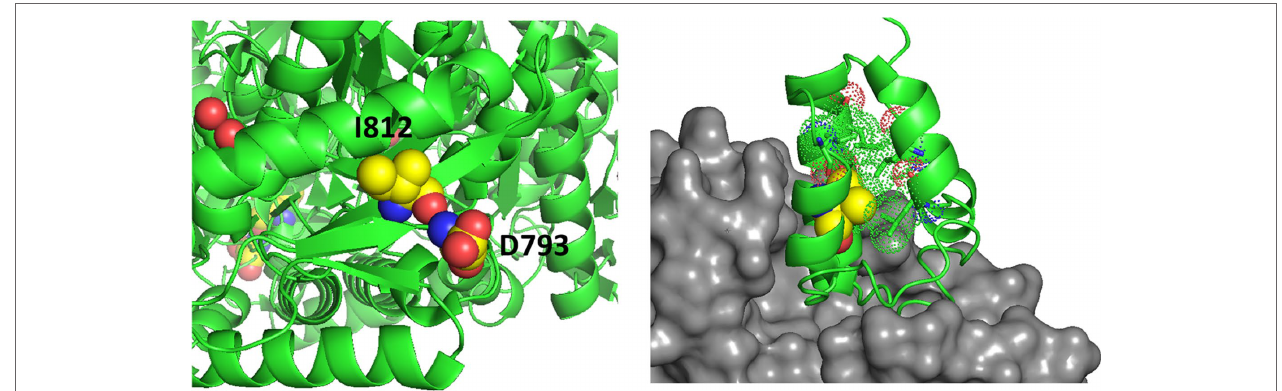
FiGURe 5 | Left panel , D793 and I812 are adjacent on parallel β -strands making backbone hydrogen bonds. Right panel , the structure of a phosphopantetheinyl transferase ( gray surface ) in complex with an ACP (acyl carrier protein) domain ( green ribbon ) shows that initial modification of the ACP domain serine ( spheres ) requires substantial access to the ACP surface. ACP helices 1 and 2 and the connecting loop lie on the surface of the transferase. The side chain of V330 ( yellow spheres ) packs in the interior of the ACP domain helical bundle. The substitution with Phe (rs2886059) will clash with surrounding residues ( dots ), likely causing a shift of the helix which contacts the transferase domain ( gray surface ) and interfering with binding.